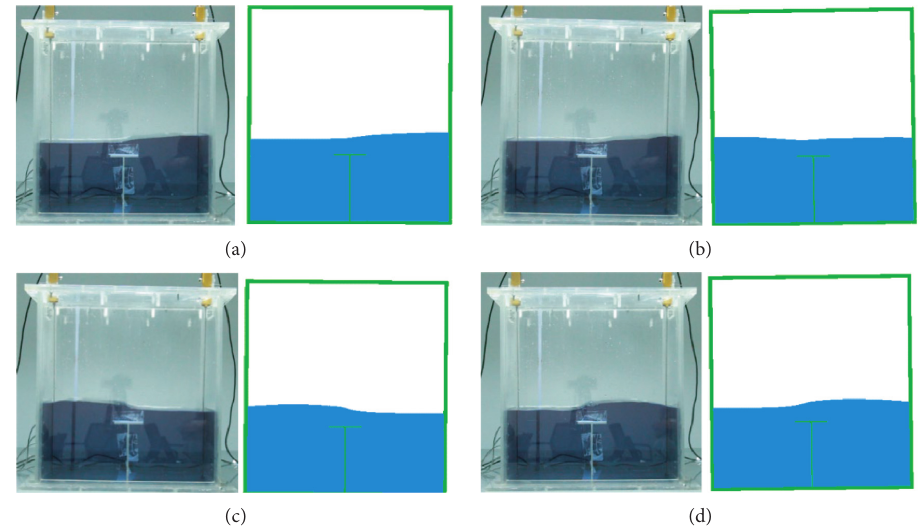
Figure 11: Evolution of free surface profile at (a) (t) � 2s; (b) (t) � 3.1s; (c) (t) � 3.5s; (d) (t) � 4.3s.